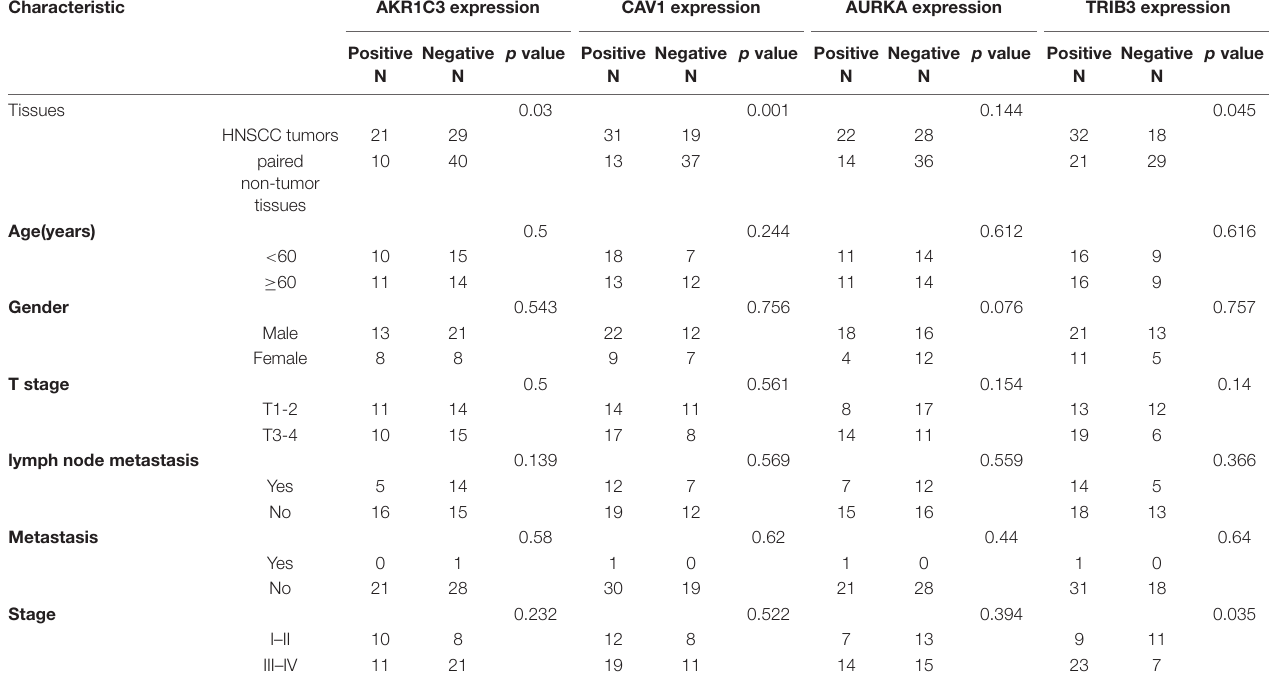
TABLE 2 | Associations between the clinicopathological characteristics and protein expression in HNSCC.